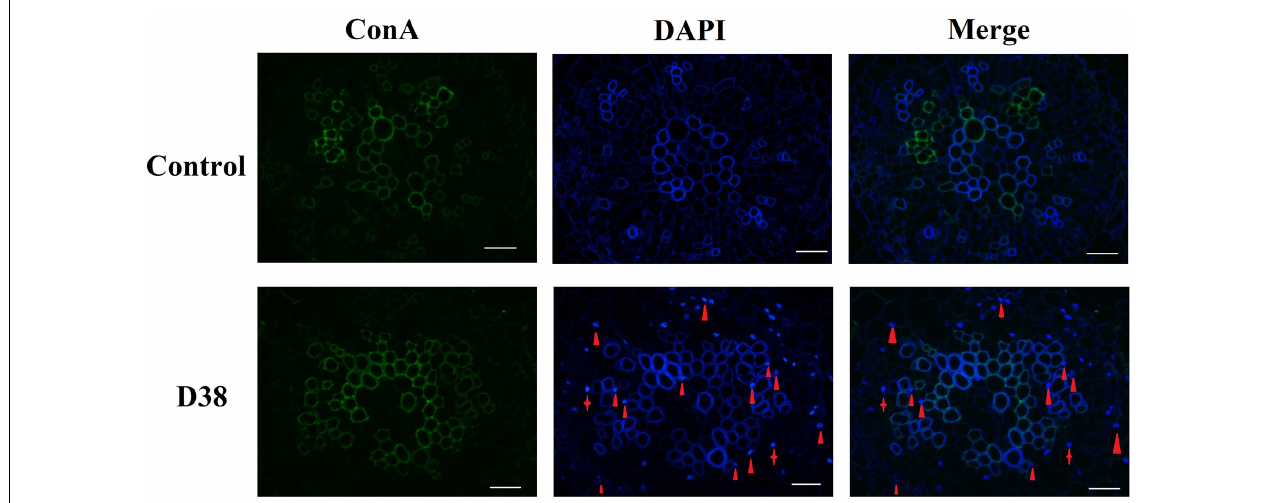
FIGURE 4 | The transection of endophytic fungus D38 localization in S. miltiorrhiza hairy roots after immunofluorescence staining. Green: ConA-FITC; Blue: DAPI. Red triangle indicated endophytic fungus D38 located in root intercellular space, while red shuriken indicated endophytic fungus D38 located in root cell (magnification 400 × ).